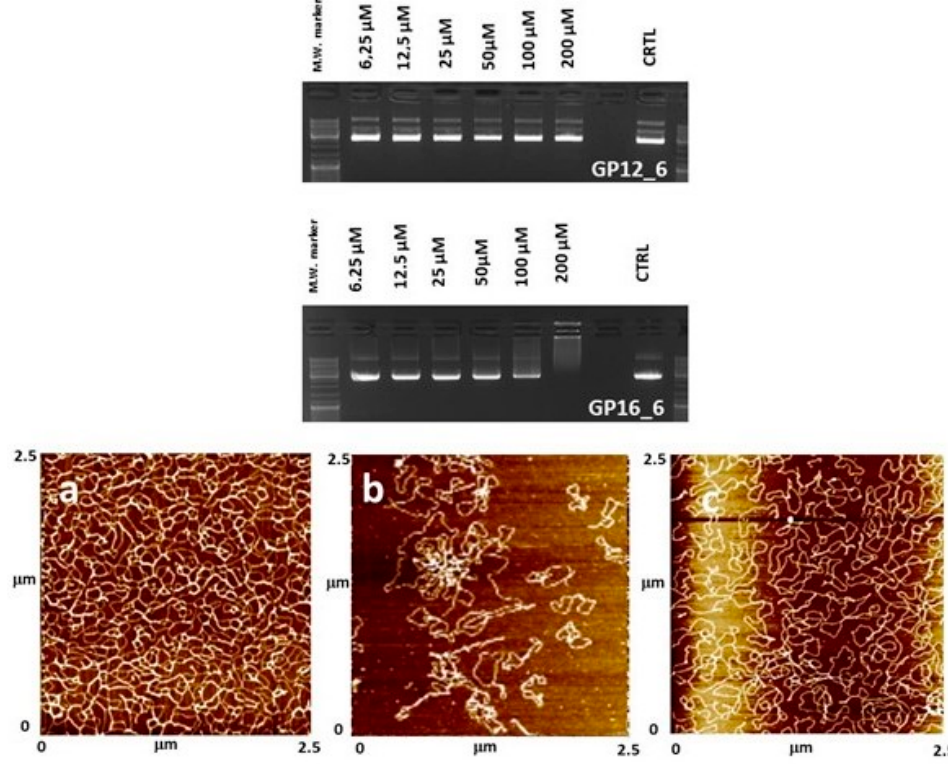
Figure 3. Upper: EMSA experiments showing complexation of GP12_6 with circular plasmid pEGFP-C1 as a function of surfactant concentration ( µ M), compared with GP16_6 [18]. Only the plasmid was used as a negative control, which is completely unshifted. Cationic lipid 100 µ M corresponds to N/P ≈ 1. Lower: AFM images of DNA plasmid incubated with the hydrogenated compounds: ( a ) plasmid + GP12_6; ( b ) plasmid + GP16_6; ( c ) plasmid alone as control. All images were obtained with supercoiled 0.5 nM pEGFP-C1 plasmid deposited onto mica and with the microscope operating in tapping mode in the air at N/P ratio =